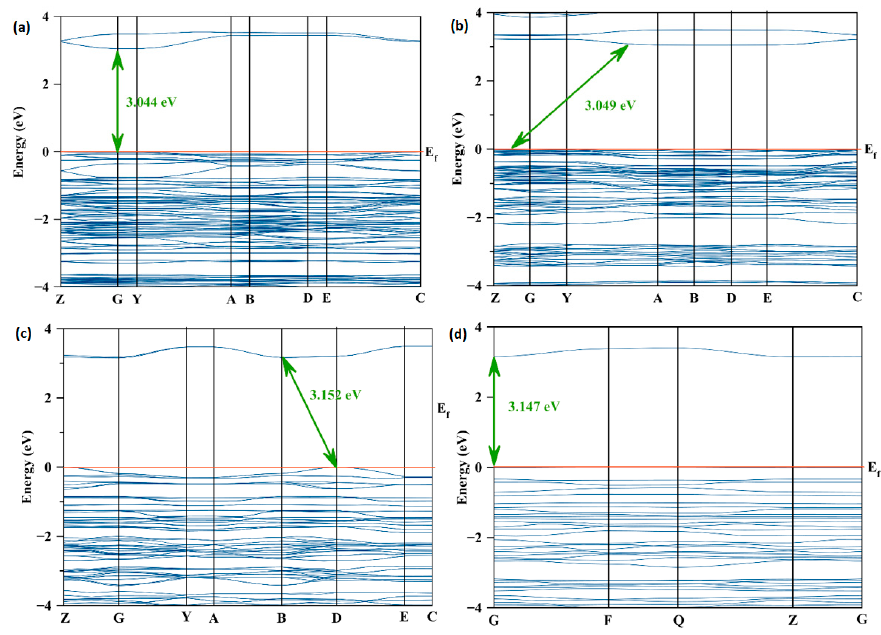
Figure 3. Electronic band structure of four tin (IV)-based hybrids: ( a ) (NH 3 (CH 2 ) 2 C 6 H 5 ) 2 [SnCl 6 ], ( b ) (C 6 H 10 N 2 )[SnCl 6 ], ( c ) (C 9 H 14 N) 2 [SnCl 6 ], and ( d ) (C 8 H 12 N) 2 [SnCl 6 ].